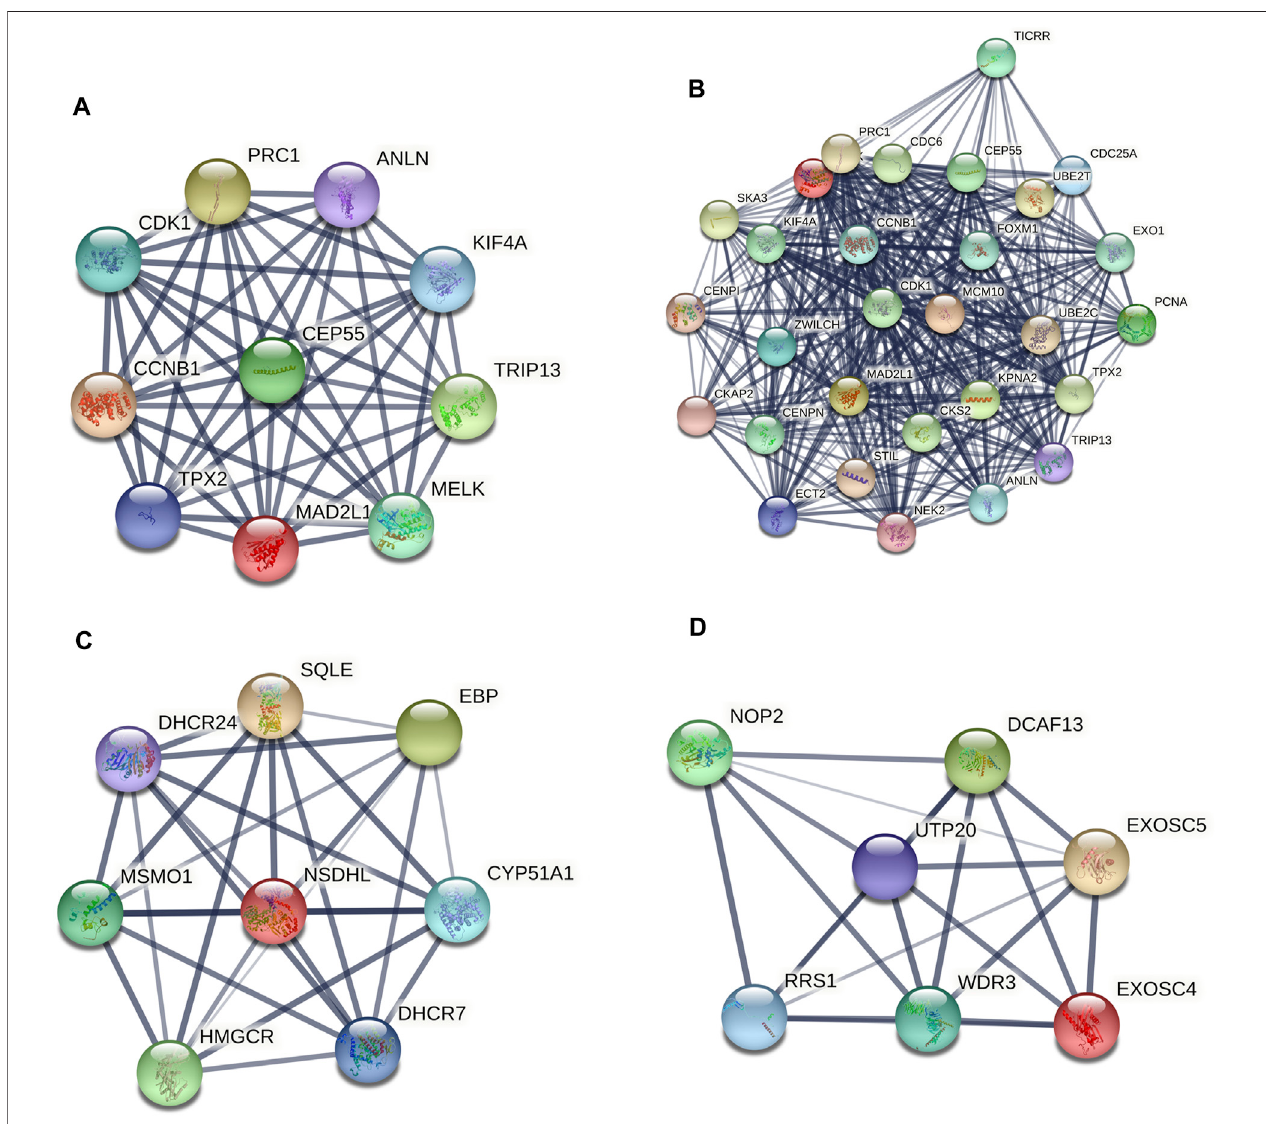
FIGURE 2 | The protein – protein interaction (PPI) network of the top 10 hub genes (A) and top three modules from the protein-protein interaction network: module 1 (B) , module 2 (C) , module 3 (D) .